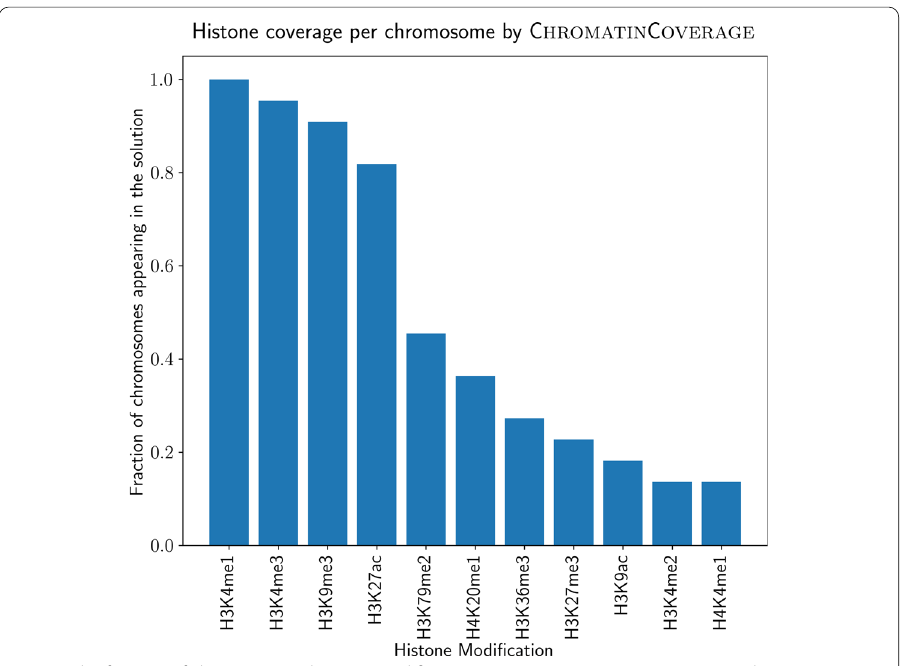
Fig. 2 The fraction of chromosomes histone modifications appearing in C hromatin C overage solution on human ES cells, where C hromatin C overage is run independently for each